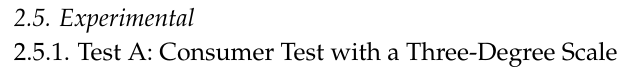
Figure 7. Wall cladding panels made of MBC (photo by A.B.).